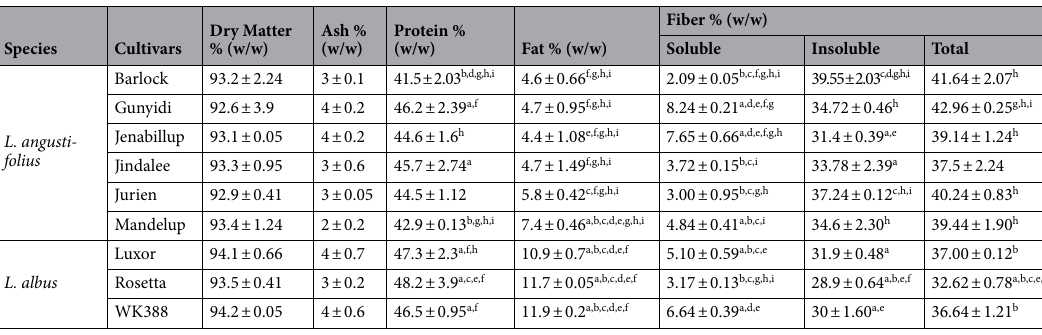
Table 2. Macronutrient composition of different lupin cultivars. Data are means of three replicates with standard deviations (SD). Data within the same column with different superscripts are significantly different, pair-wise comparison by Post Hoc Tukey test ( a P < 0.05 vs. Barlock; b P < 0.05 vs. Gunyidi; c P < 0.05 vs Jenabillup; d P < 0.05 vs. Jindalee; e P < 0.05 vs Jurien; f P < 0.05 vs. Mandelup; g P < 0.05 vs Luxor; h P < 0.05 vs Rosetta; i P < 0.05 vs